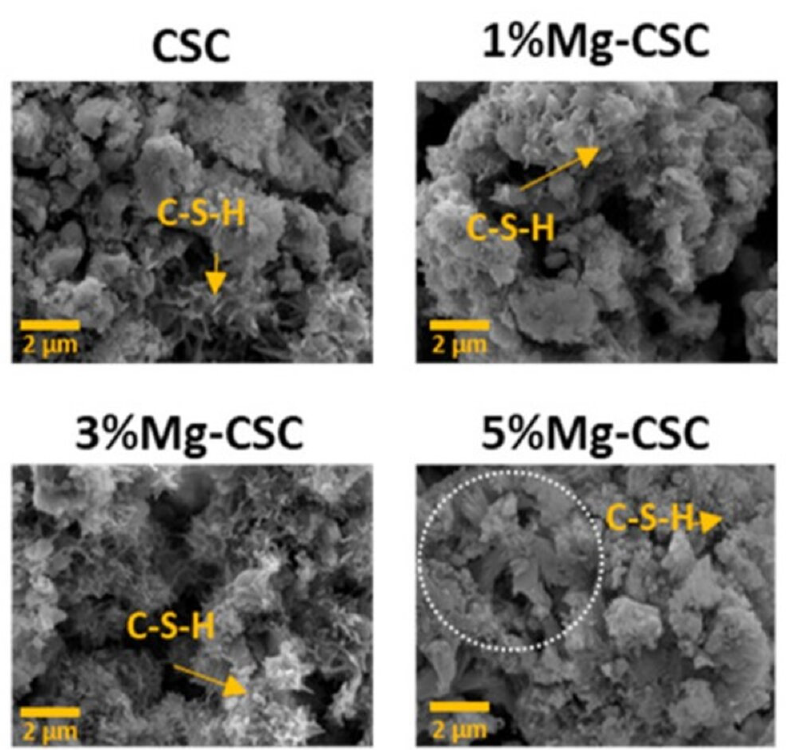
Figure 9. SEM images of calcium silicate and co-synthesized 1%, 3%, and 5% Mg-calcium silicate (Mg-CSC) cements after immersion in simulated body fluid (SBF) for 21 days; all samples presented the foil-like C-S-H aggregates (yellow arrows); 5% Mg-CSC showed hydroxyl-magnesium-silicate minerals [139].